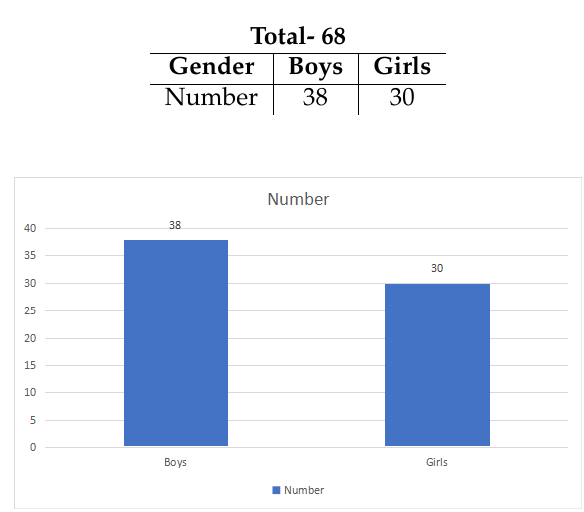
Figure 1. Graphically representation of distribution of patients